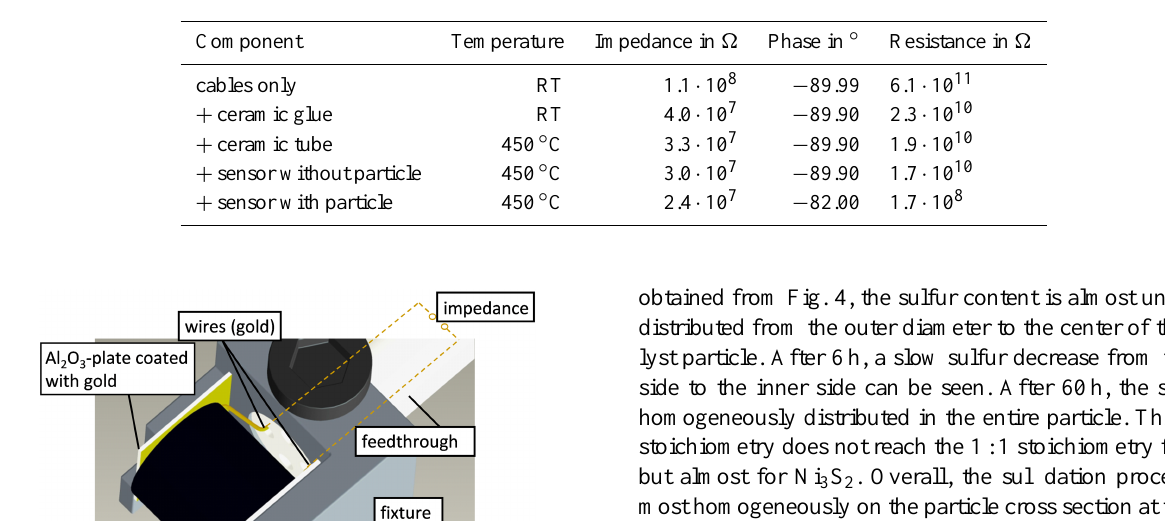
Figure 1. Scheme of the experimental setup. Table 1. Electrical data of the sensor setup with and without a sensor particle. The resistance of the sensor particle is at least 2 decades lower than the sensor setup.